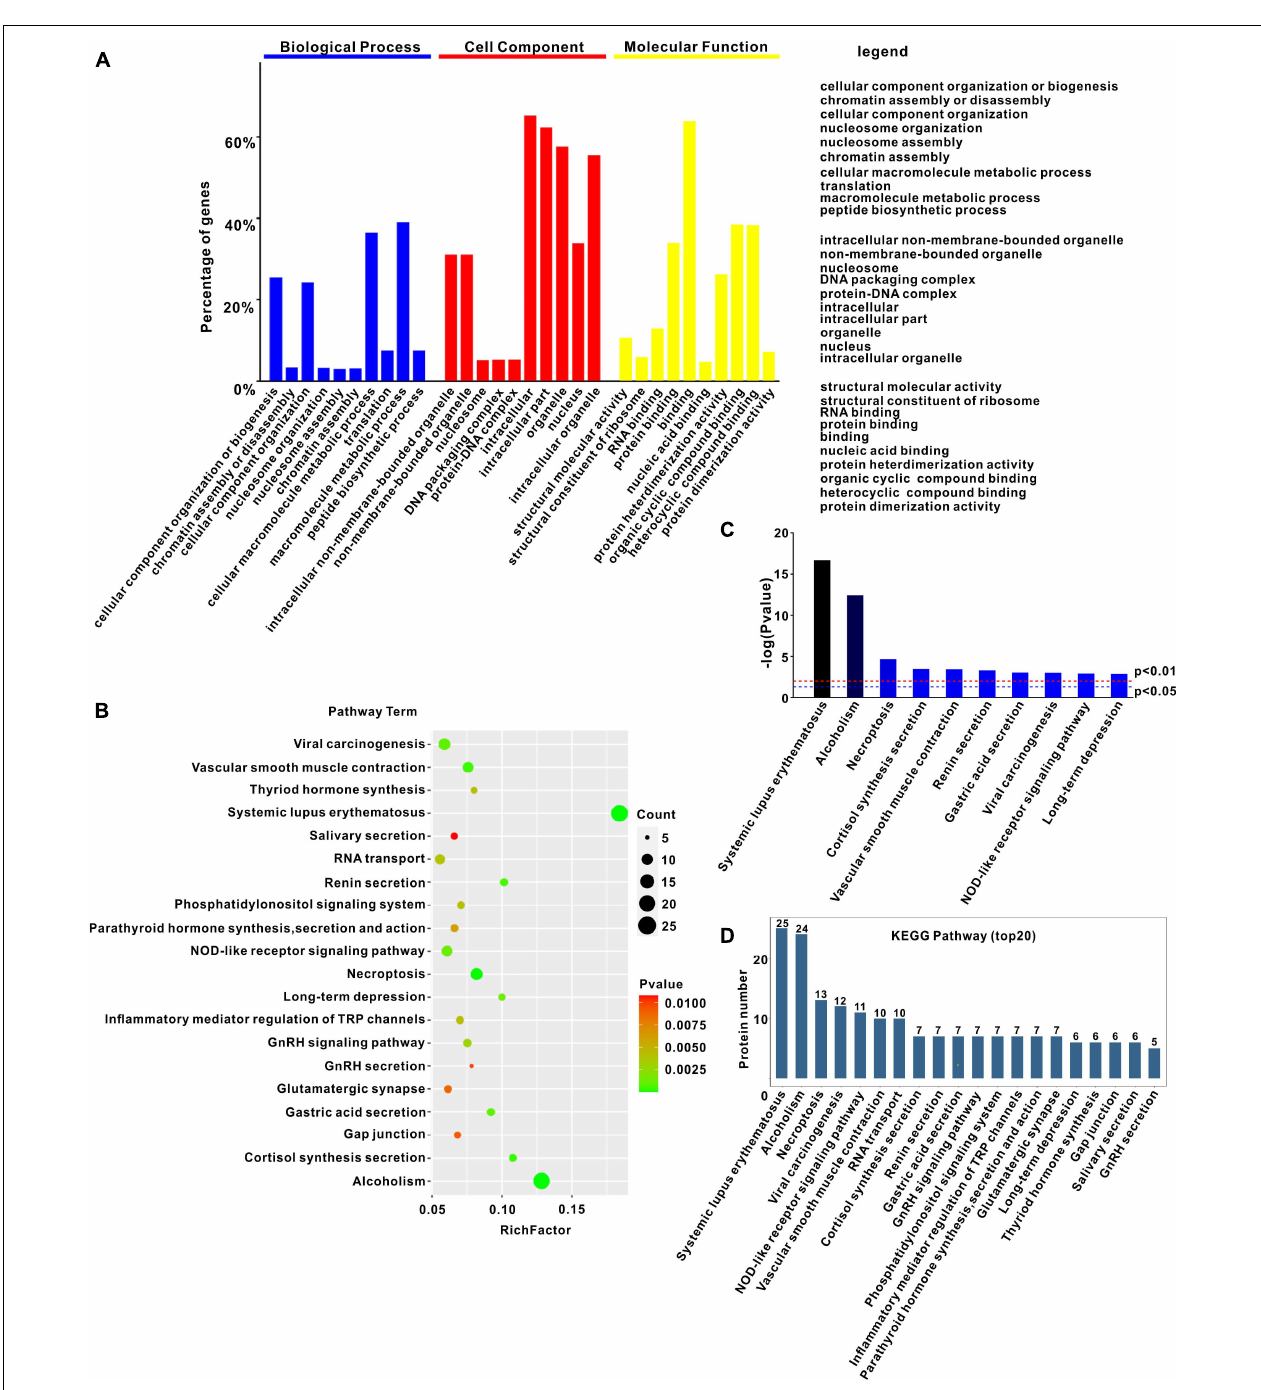
FIGURE 1 | Gene ontology and KEGG pathway enrichment analysis of interactions. (A) Annotation of proteins interacting with PCV3 Cap using Gene Ontology. (B) KEGG pathway analysis of cellular proteins interacting with PCV3 Cap. (C) Enrichment of differential pathway terms in KEGG pathways. Cut-off P -value of 0.01 was used to reduce false discovery rate. (D) Top 20 KEGG